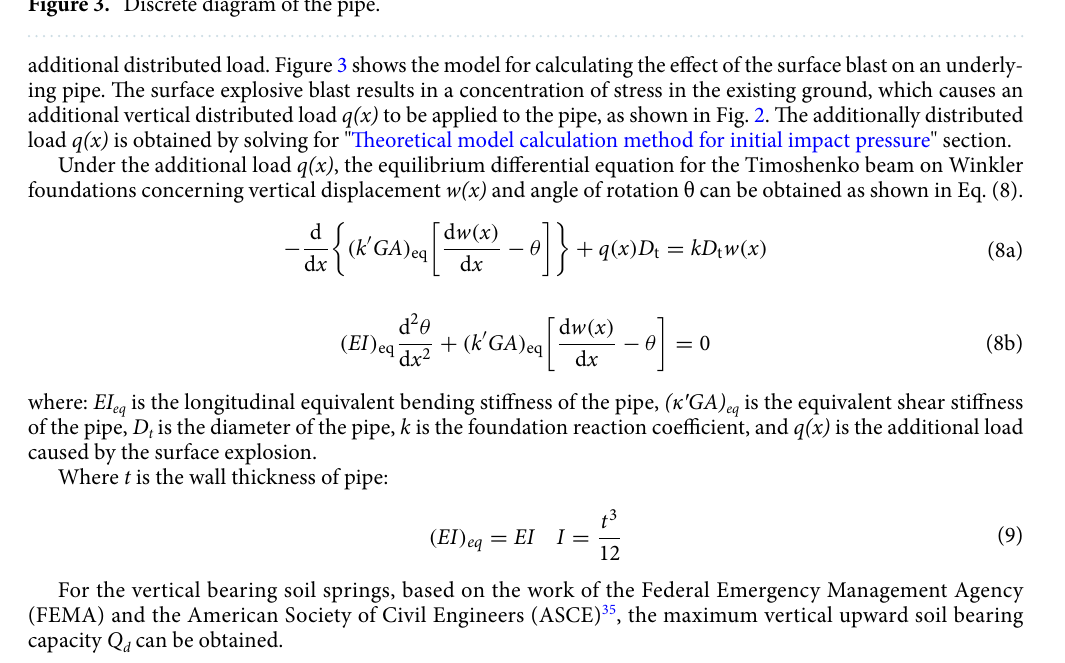
Figure 3. Discrete diagram of the